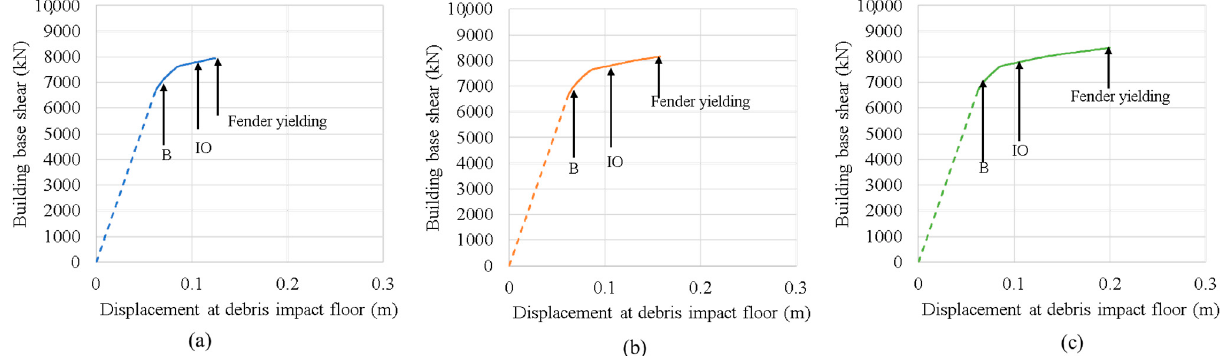
Figure 15. Capacity curve due to debris impact after applying hydrodynamic force: ( a ) building with fender F1, ( b ) building with fender F2, and ( c ) building with fender F3.